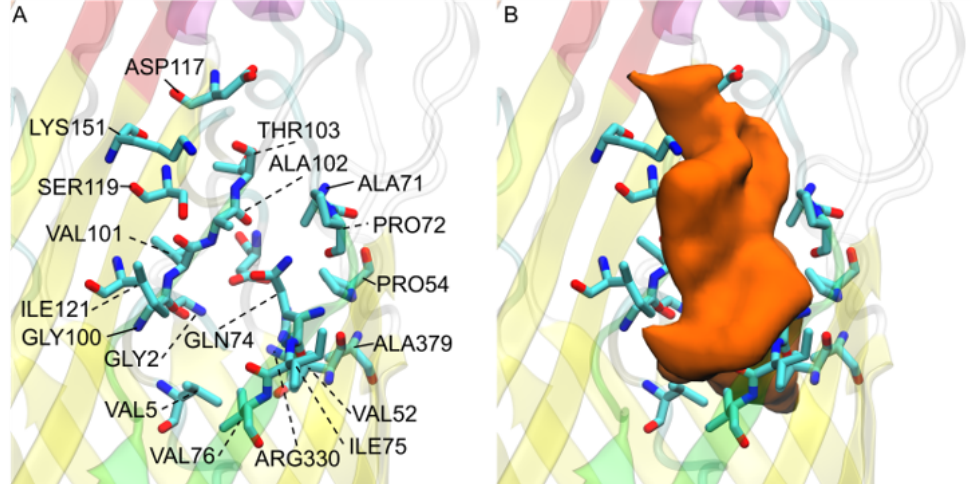
Figure 11. V. cholerae vca0862 FA interacting residues: ( A ) residue names and locations; ( B ) observed transport channel shown from a surface view of all docked FAs (orange) shown with its relation to the displayed residues. The L3 loops is colored red, the L4 loop is colored orange, and the S3 kink is colored green for